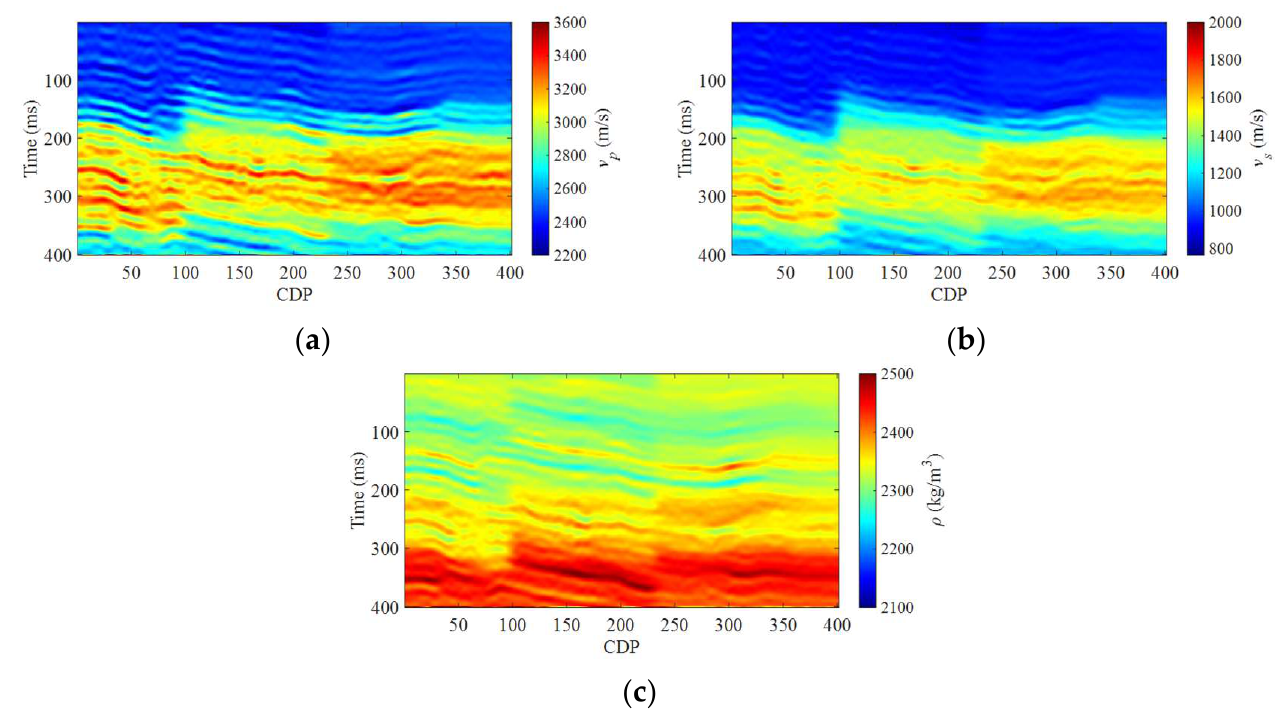
Figure 15. Prestack seismic inversion results of ( a ) v p , ( b ) v s , and ( c ) ρ by using the initial models shown in Figure 13 from KI.